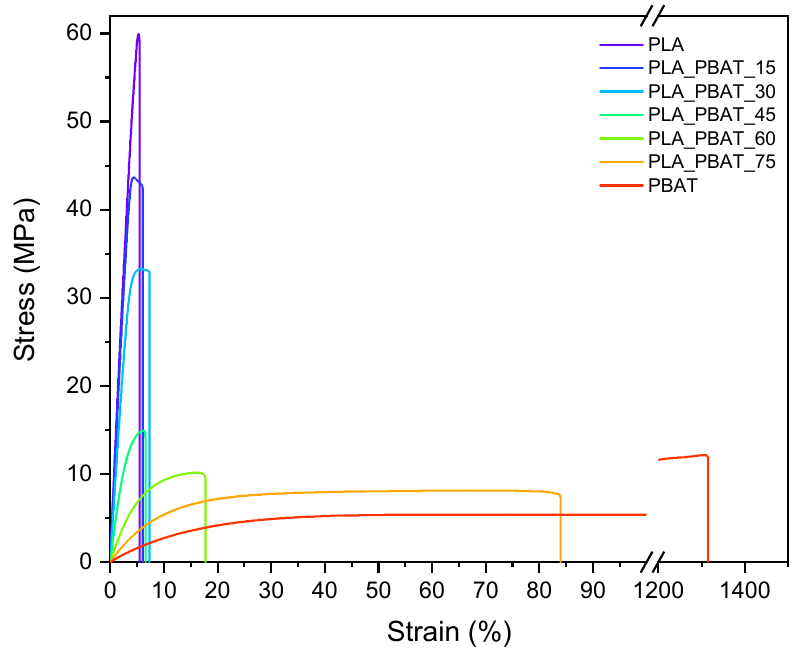
Figure 8. Representative stress–strain curves of neat PLA, neat PBAT and PLA/PBAT